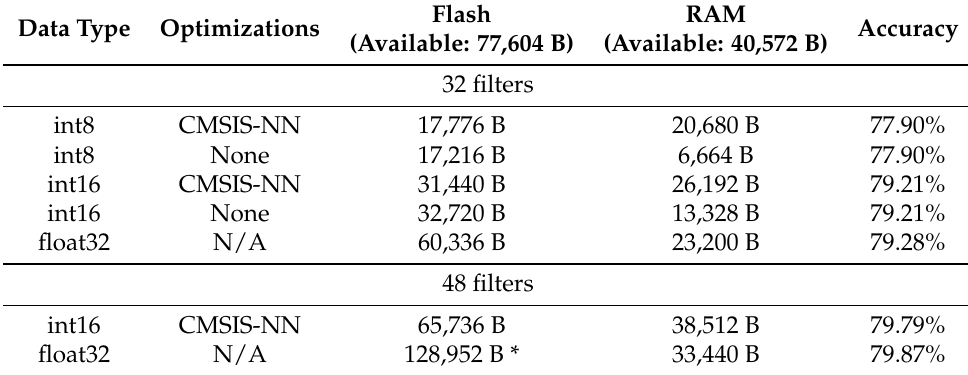
Table 2. Flash usage and static RAM allocation of the deep neural network (code and